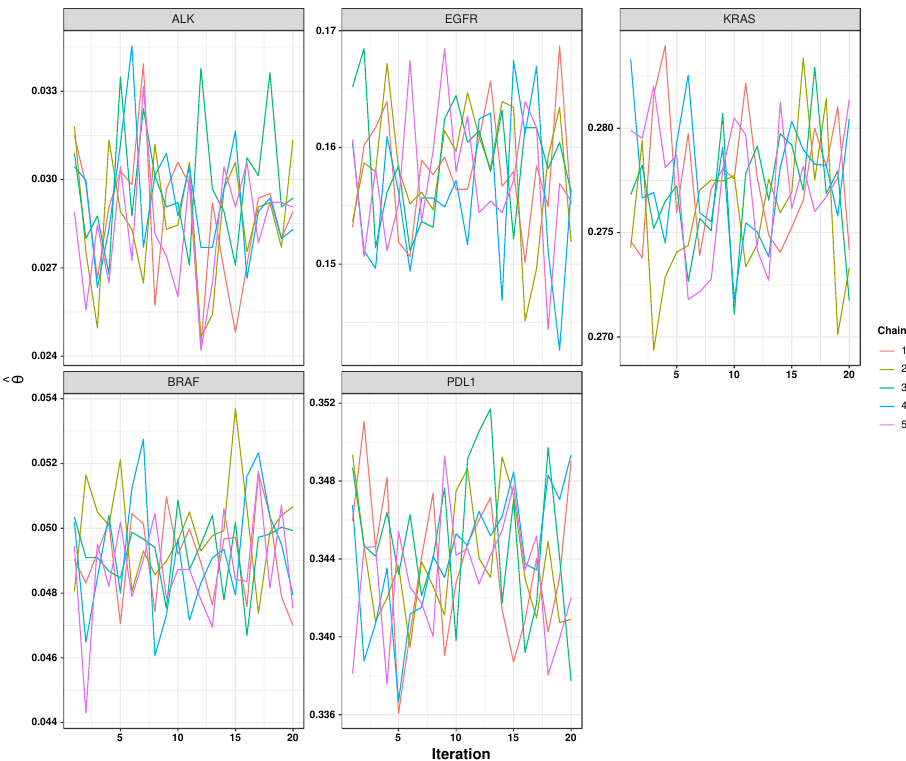
Figure A1. Convergence of MITABNET in one sample dataset. Trace plot of average parameter estimate ¯ θ for each of the biomarker